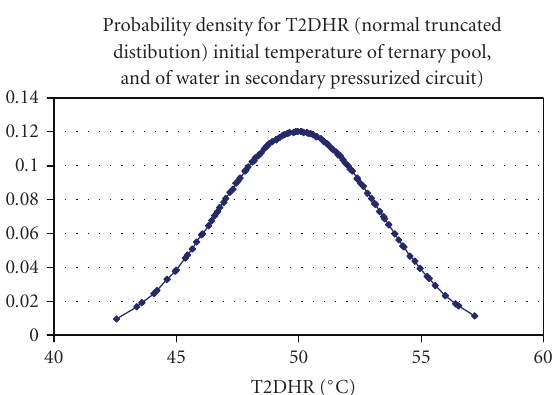
Figure 14: RMPS reference case—maximum temperature in the core region evolutions.